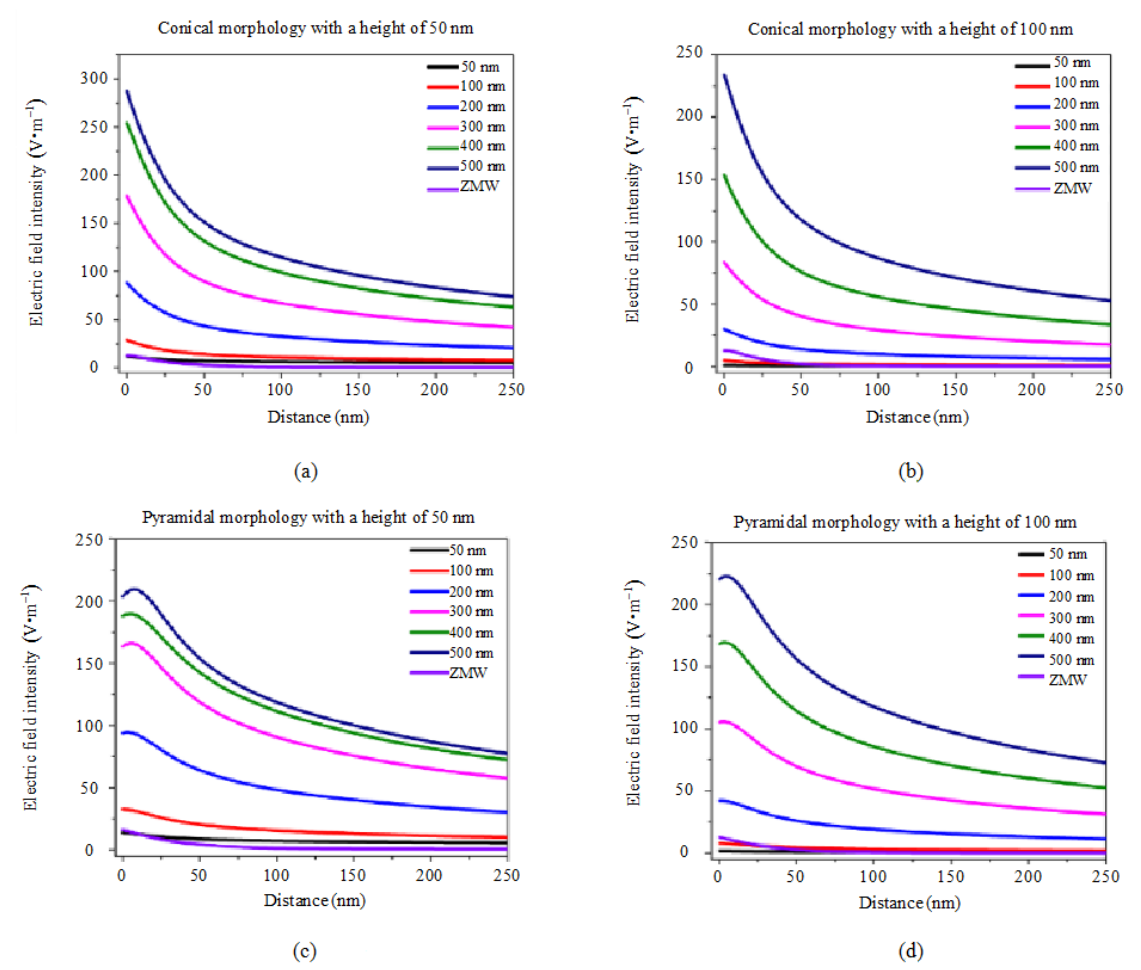
Fig. 5 Comparison of the near field electric field intensity along the z -axis distance from the water/dielectric interface of: (a) the conical NFS with a different D B and a ZMW with a diameter of 50 nm and a height of 50 nm, (b) the conical NFS with a different D B and a ZMW with a diameter of 50 nm and a height of 100 nm, (c) the pyramidal NFS with a different W B and a ZMW with a diameter of 50 nm and a height of 50 nm, and (d) pyramidal NFS with a different W B and a ZMW with a diameter of 50 nm and height of 100